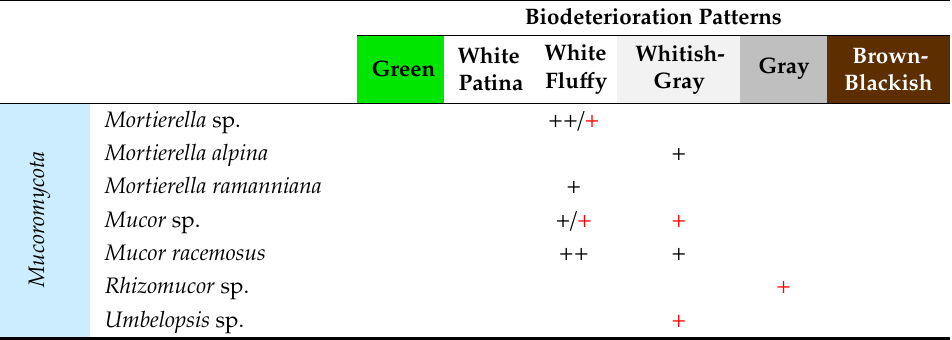
Table 2. Fungal deteriogens associated to biodeterioration patterns found in Italian